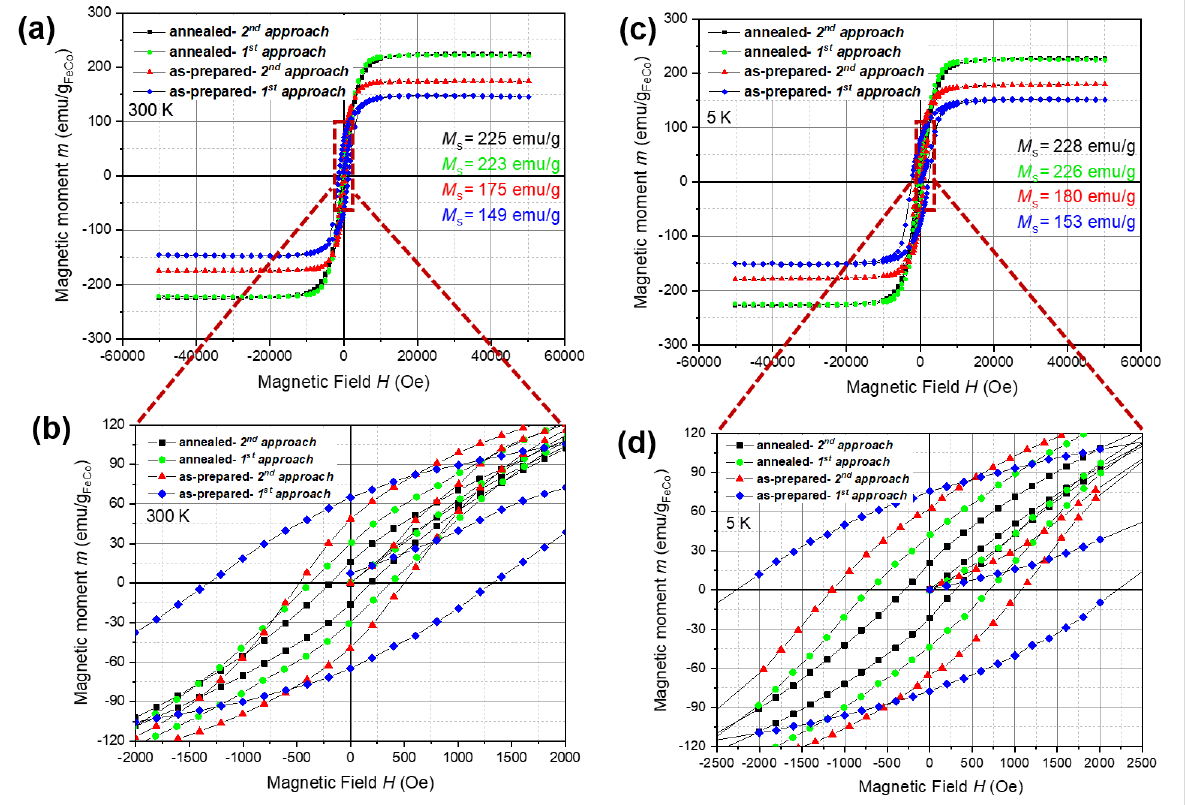
Figure 7: Hysteresis curves measured at a) 300 K and c) 5 K for the annealed and the as-prepared Fe 50 Co 50 @CNT material prepared by the first and second approaches. Data are normalized to the amount of magnetic material as obtained from the TGA measurements. Enlarged view of the hysteresis curves in b) 300 K and d) 5 K show the variation of the material hardness upon annealing.